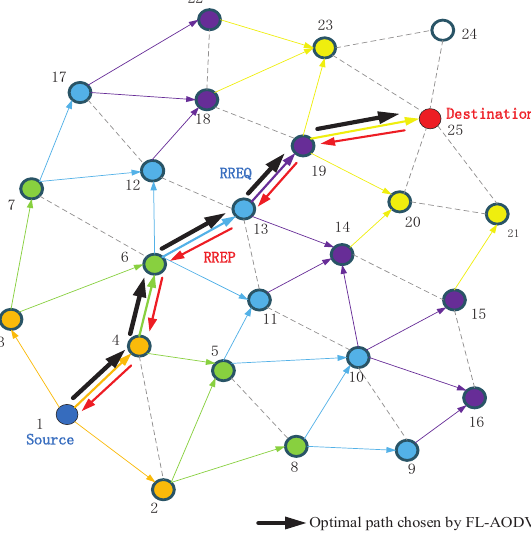
Figure 8. The route discovery process of